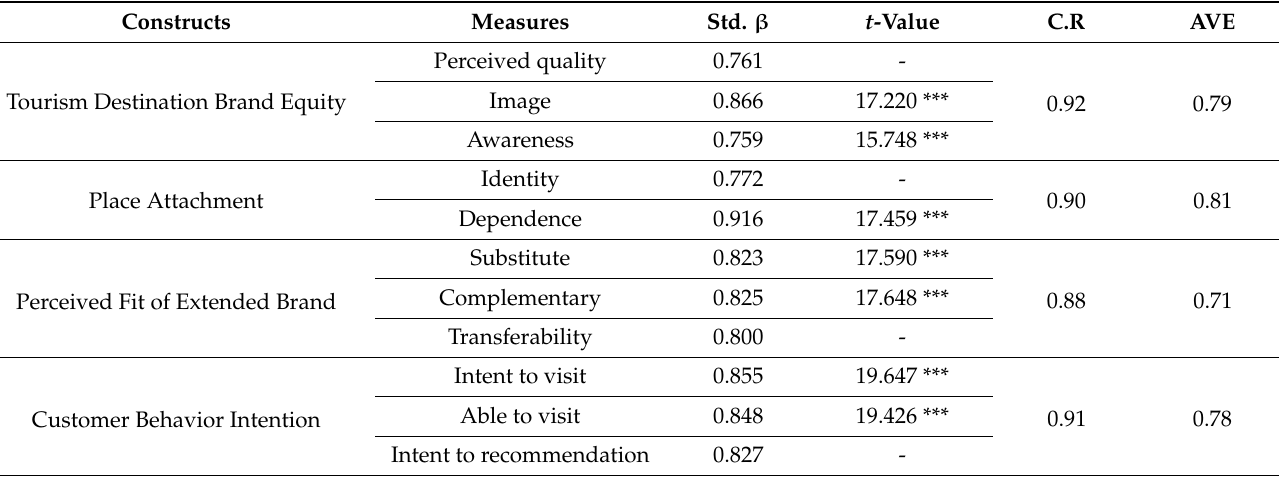
Table 2. Result of Confirmatory Factor Analysis.